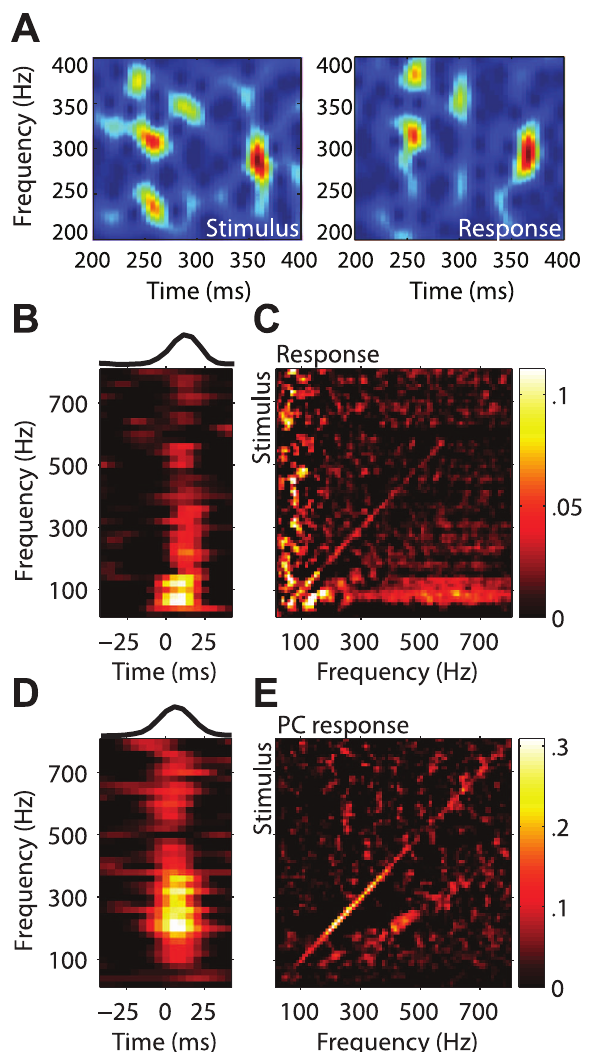
Figure 3. Cross-correlation of the spectral content of the stimulus with the spectral content of the response. (A) Spectrogram of one band-pass noise stimulus (left) and corresponding spectrogram of a single neuron response (right). (B) Average cross- correlation of stimulus and response spectrograms for the population of PL neurons, showing correlations between stimulus frequency and responses at the same frequency for different lags. Top inset: cross- correlation averaged across frequencies (peak lag at , 18 ms) (C) Cross- correlations as in (B), but showing stimulus versus response frequency at the optimal lag. (D,E) Same as in (B,C) but for a population of PC afferents (peak lag at , 5 ms).